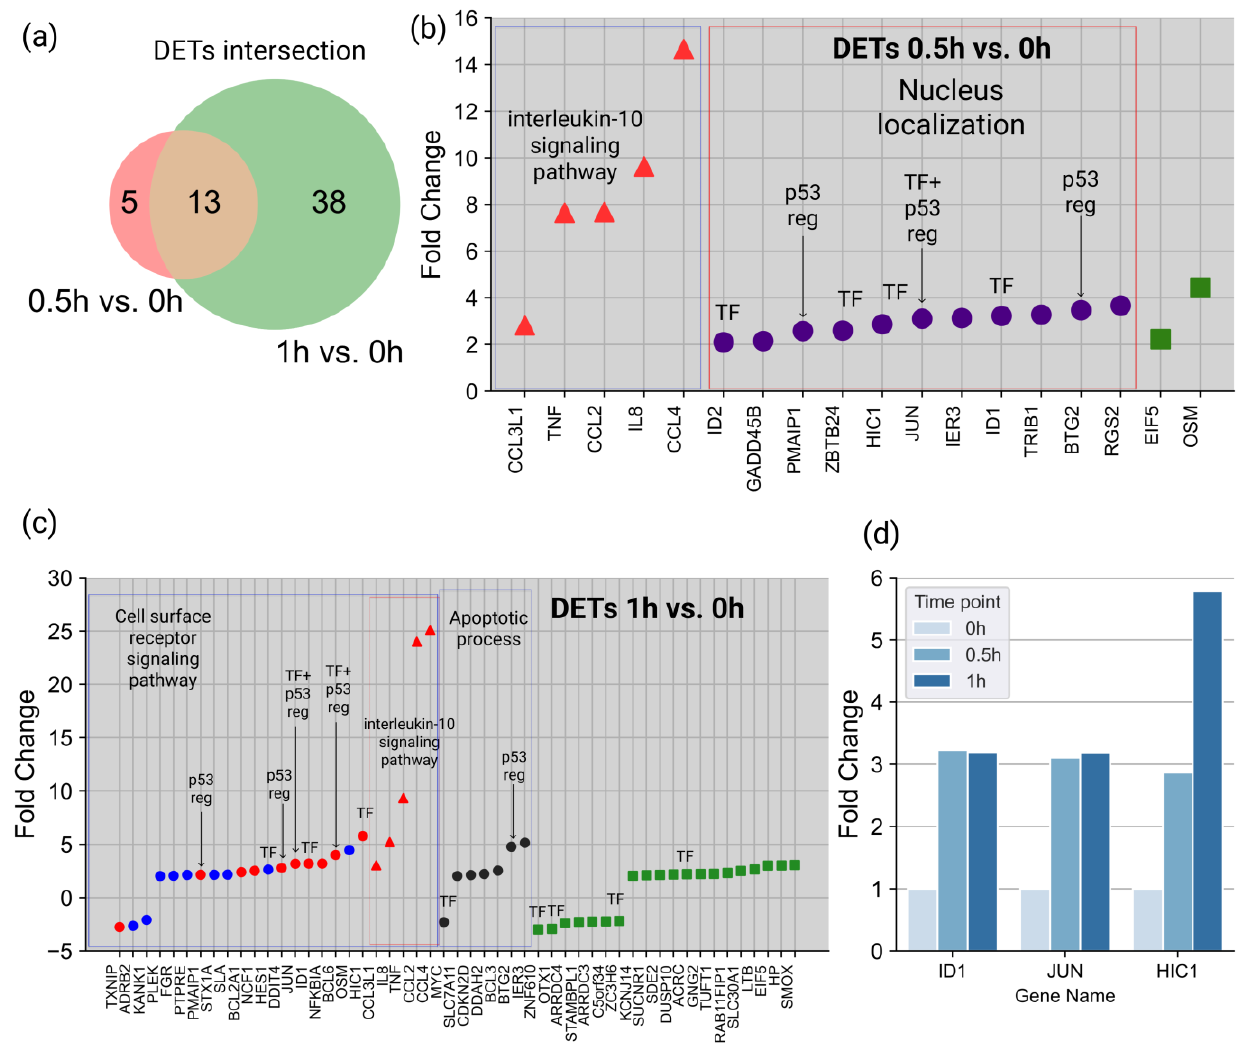
Figure 2. Transcriptomic profiling of whole-cell lysate of HL-60 cells at 0.5 and 1 h after ATRA treatment. ( a ) Venn diagram shows intersection of differentially expressed transcripts (DETs) at 0.5 and 1 h after the ATRA treatment. DETs expression differences (fold change > 2, p -value < 0.05) ( b ) at 0.5h and ( c ) at 1 h after the ATRA treatment compared to control. Red triangles indicate DETs involved in the interleukin-10 signaling pathway, purple circles indicate DETs with nuclear localization, blue circles indicate DETs involved in the cell surface receptor signaling pathway (GO:0007166), black circles indicate DETs involved in the apoptotic process (GO:0006915) and red circles indicate DETs involved in both the cell surface receptor signaling pathway and the apoptotic process. TF indicates DETs with transcription factor activity (PC00264), p53 reg with an arrow indicates DETs that are involved in p53 regulation (R-HSA-3700989). ( d ) TFs ID1, JUN, and HIC1 expression differences (fold change > 2, p -value < 0.05) at 0, 0.5, and 1 h after ATRA